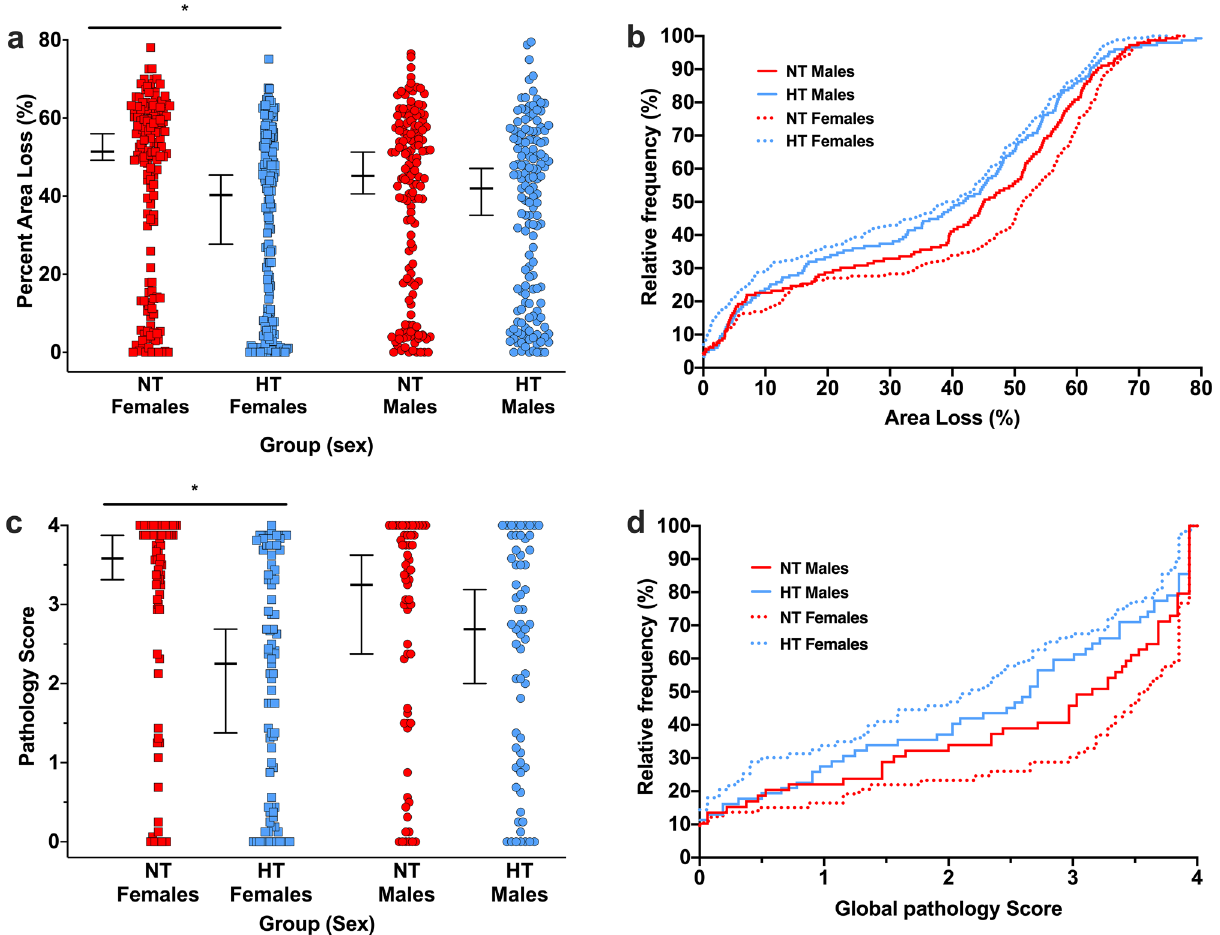
Figure 5. Sex effects of hypothermic neuroprotection. ( a ) Median (95% CI) area loss in the NT group was 51.4% (49.2–56.0%; n = 159) in females, and males 45.2% (40.6–51.3%; n = 146) in males. In the HT group, median area loss was 40.3% (27.7–45.4%; n = 170) in females, and 42.0% (35.1–47.1%; n = 147) in males. The median differences between the NT and HT groups were 11.1% (21.6% neuroprotection) in females, and 3.2% (7.1% neuroprotection) in males. ( b ) Cumulative frequency distribution plot of area loss. ( c ) Median (95% CI) global pathology score in females was 3.6 (3.3–3.9, n = 73) in the NT group, and 2.3 (1.4–2.7, n = 83) in the HT group. In males, median global pathology score was 3.3 (2.4–3.6, n = 59) in the NT group, and 2.7 (2.0–3.2, n = 62) in the HT group. ( d ) Cumulative frequency global pathology score. The cumulative frequency plots suggest HT is neuroprotective across the entire range of injury in females, with neuroprotection in males centred solely around moderate injury scores (~ 20–55% area loss). *Denotes significant neuroprotection ( p <